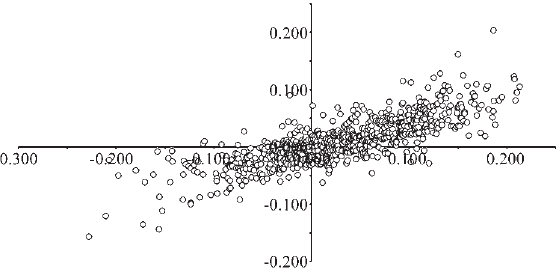
Figure 3 - Relationship between the animals’ estimated breeding values fornumberoffliescounted(FC;xaxis)andinfestationscore(FS;yaxis).